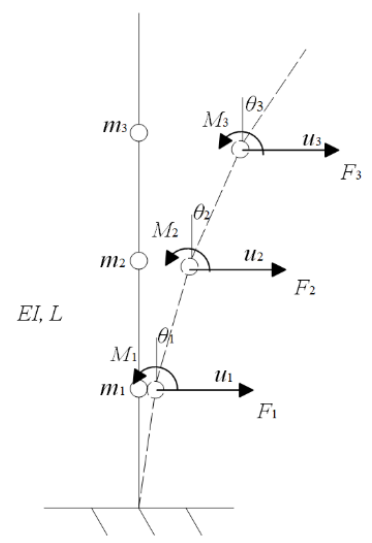
Table 1. Mass and stiffness values of the simplified MDOF turbine model. Model Part